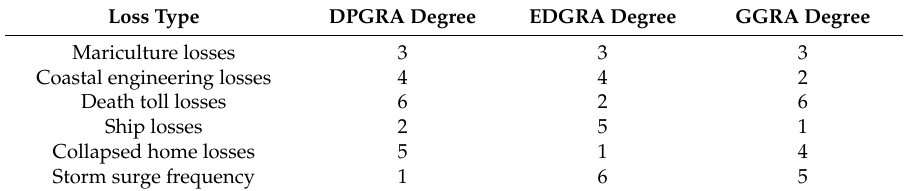
Table 3. Relative rankings of correlation between direct economic losses and various loss types and storm surge frequencies for the proposed DPGRA model and two conventional GRA